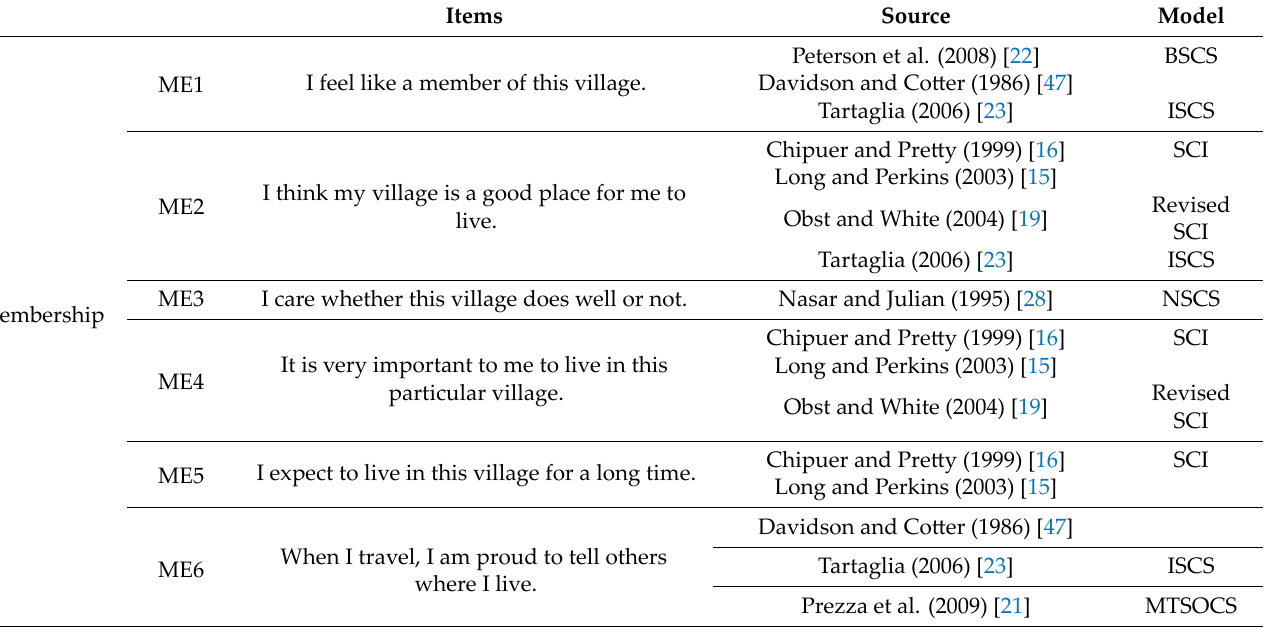
Table 1. A 28‑item sense of community scale for Chinese traditional villages. Items Source